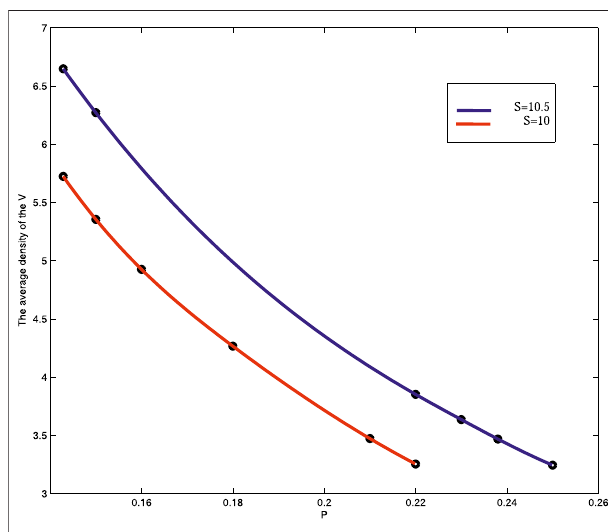
FIGURE 7 | (Color online) The average density map of vegetation is compared when precipitation is taken S (cid:1) 10 and S (cid:1) 10.5 respectively.